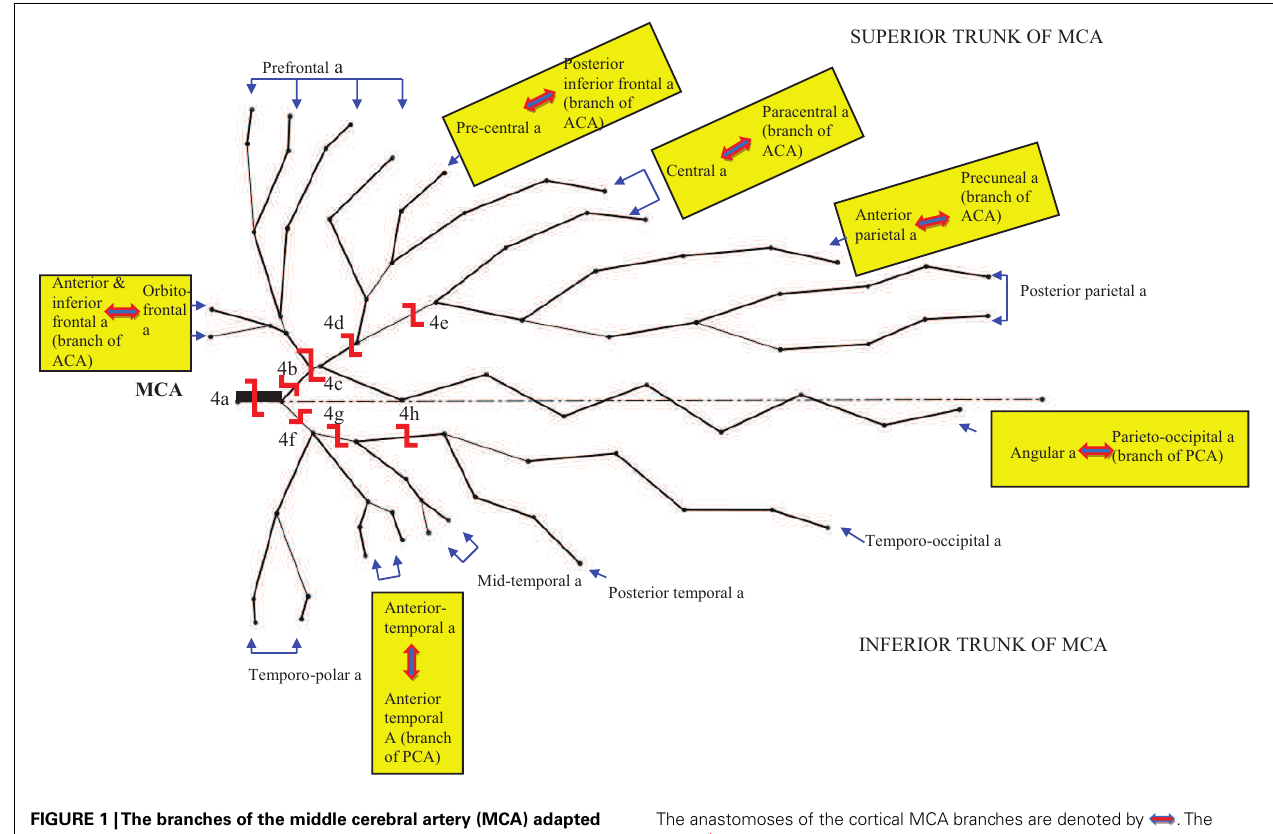
FIGURE 1 |The branches of the middle cerebral artery (MCA) adapted from Figure 2.19A by Rhoton (15) and Figure 2 by Brozici et al. (9). This figure shows an MCA with equal bifurcation into superior and inferior trunks.